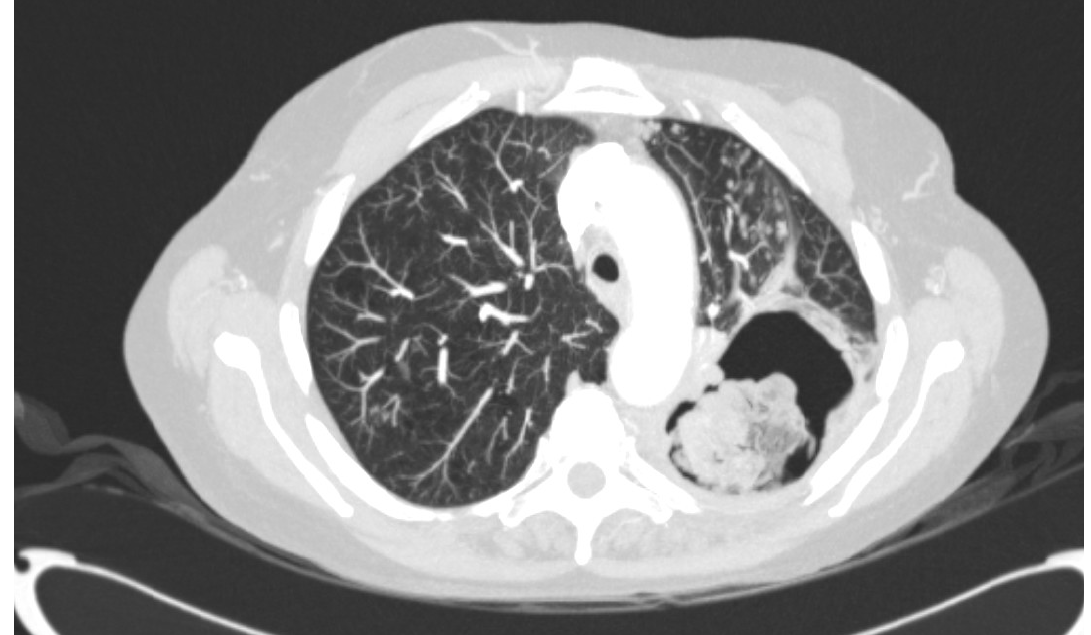
Figure 1. Chest computed tomography image showing a large pulmonary cavity in the left upper lobe with a mass lying in the cavity.